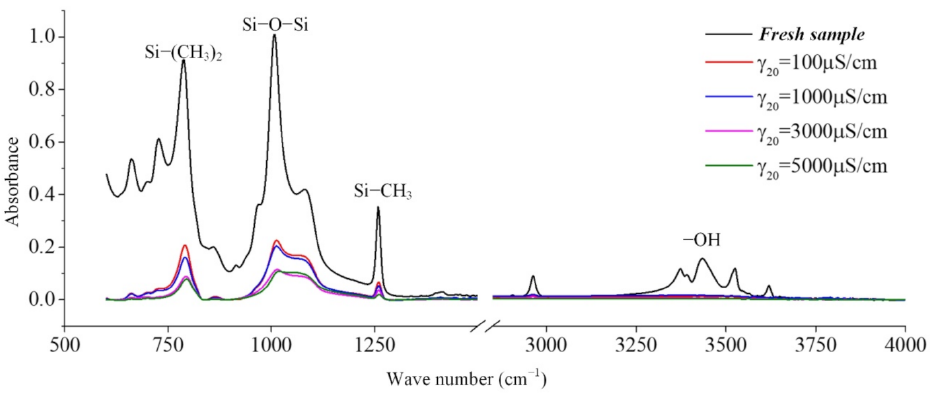
Figure 9. The effect of the water conductivity on the FTIR spectra ( t = 8 h, AC 3.6 kV).